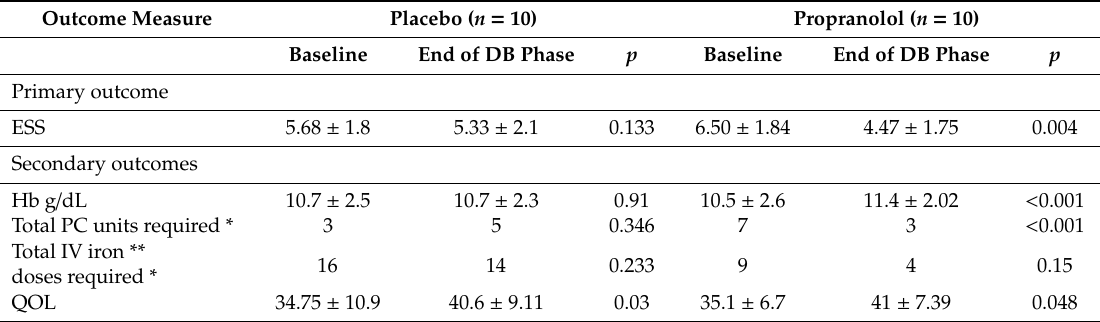
Table 3. Outcome measures during the double-blind phase of the study. (Placebo group and propranolol group are analyzed